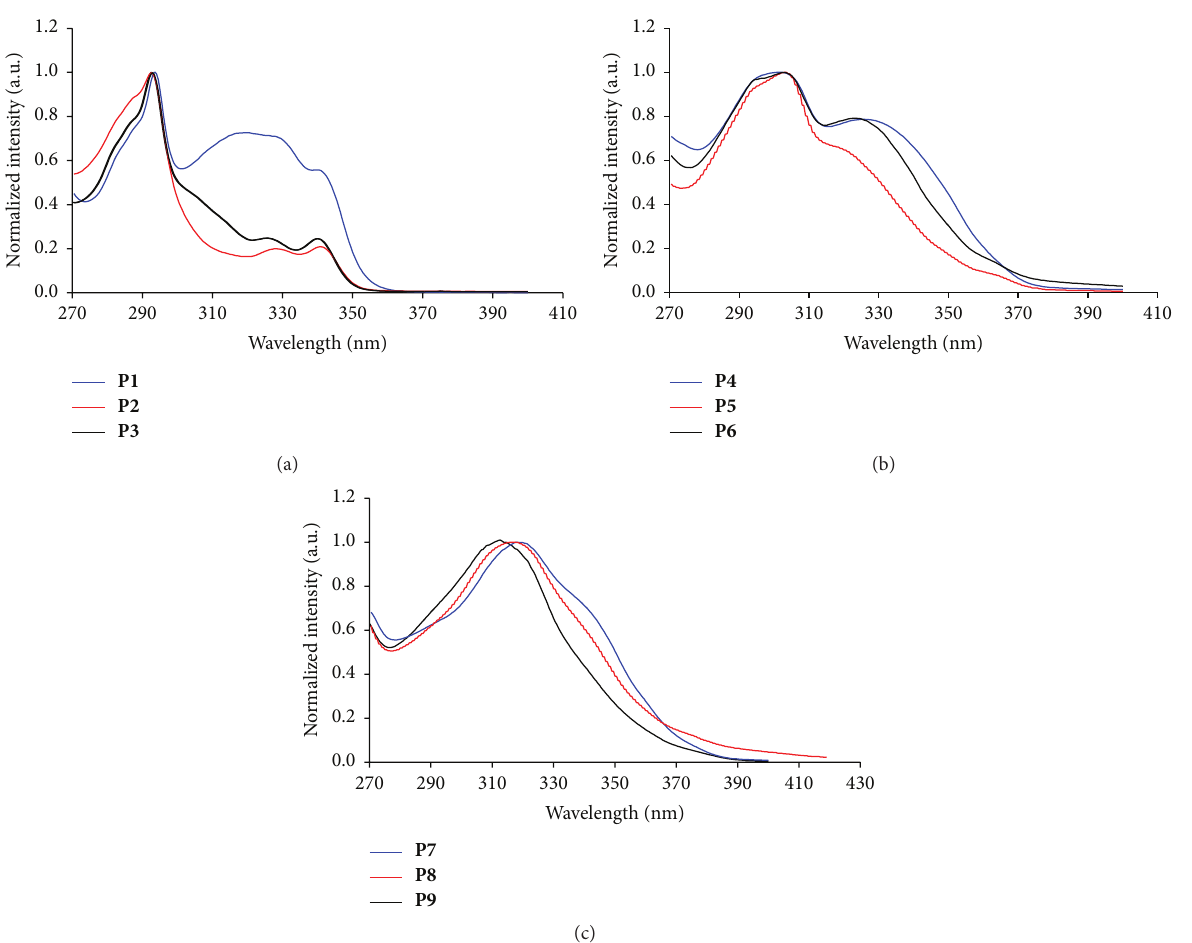
optical bandgap to the HOMO levels. Table 2 lists the values for the HOMO and LUMO levels. In the CV-experiments, the subsequent introduction of thiophene groups at the carbazole moieties in compounds P1 ( CBP ), P4 , and P7 causes decreases in the HOMO levels of − 5.69, − 5.70, and − 5.72 eV, respectively. In the case of methyl substitution on the biphenyl ring in compounds P2 , P5 , and P8 , the HOMO levels decrease to − 5.70, − 5.89, and − 5.85 eV, respectively, in comparison with P1 , P4 , and P7 . However, by changing the biphenyl core to phenyl rings for compounds P3 , P6 , and P9 , the HOMO levels are significantly affected ( − 5.62, − 5.94, and − 5.99 eV,